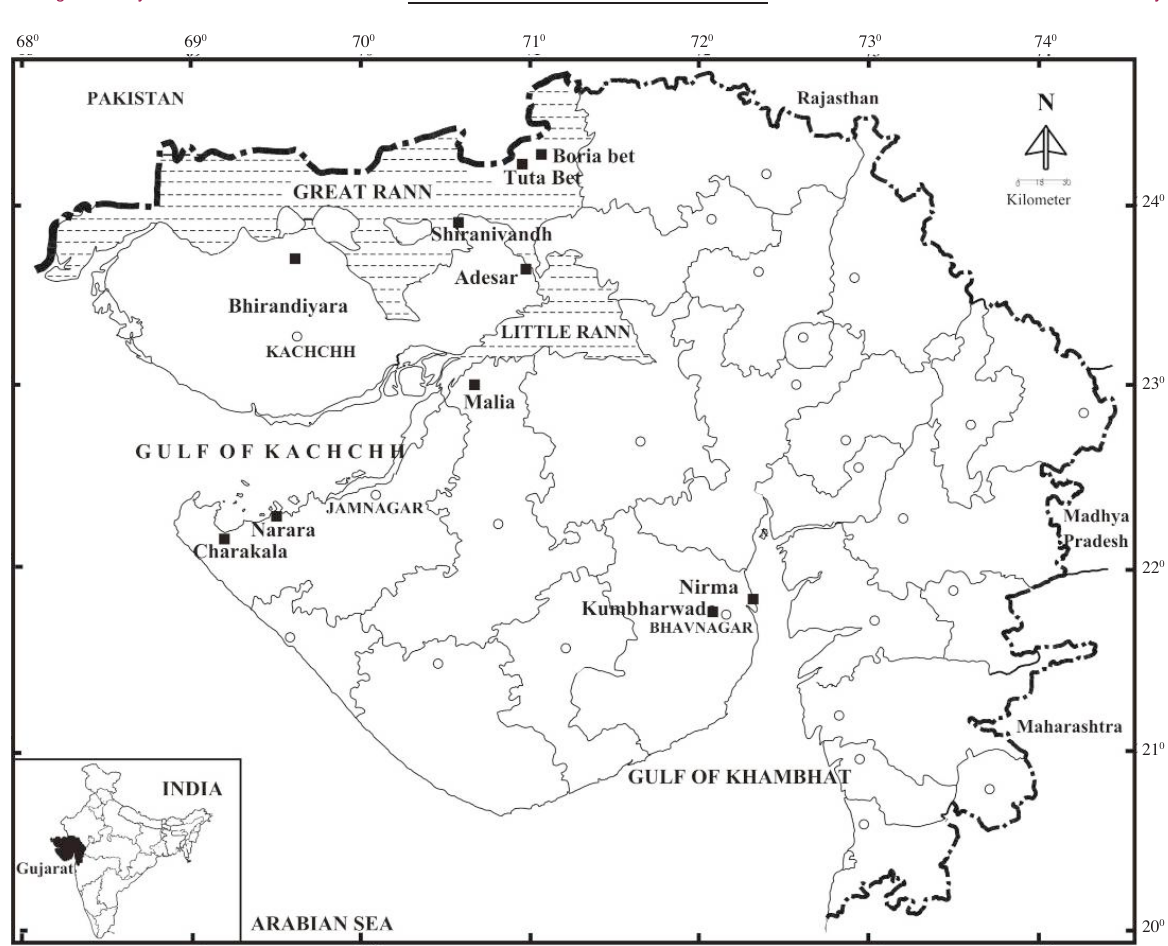
Figure 1. Sites of regular flamingos collisions in Gujarat State, India, marked as solid square